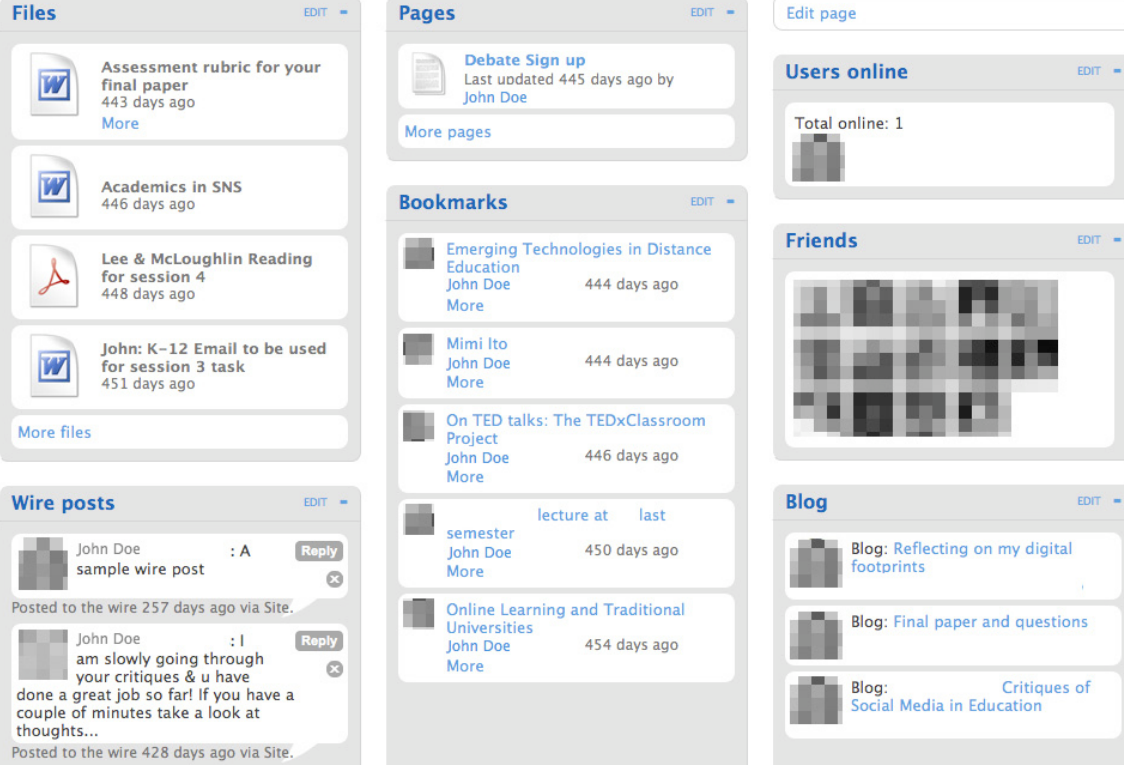
While users were able to follow other students’ activities on their dashboards, they were also able to visit affordance-specific pages in order to access updates pertaining to a specific activity. For example, Figure 4 shows the page that users were able to visit in order to view everyone’s